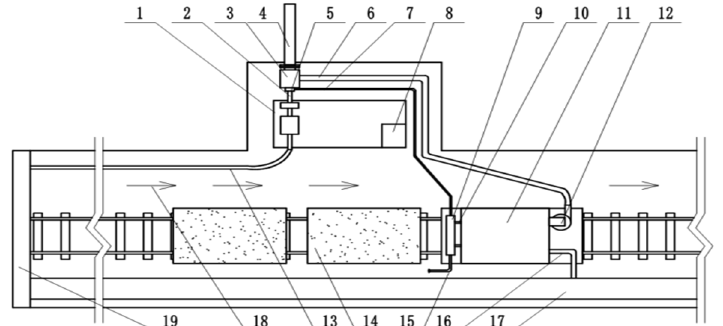
Figure 6. Layout of field-test device: 1—directional drilling rig; 2—drill pipe; 3—dust hood;